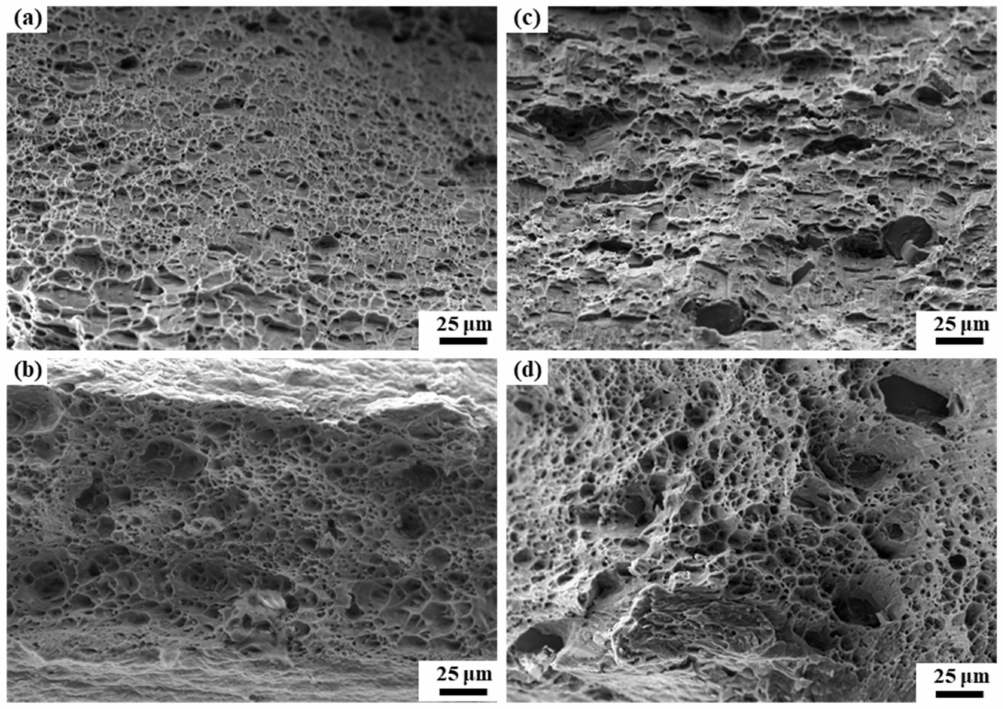
Figure 8. ( a , b ) Fracture morphologies of RTR. ( c , d ) CR 3 wt% HEAp/AMCs at 60% and 90% rolling reduction